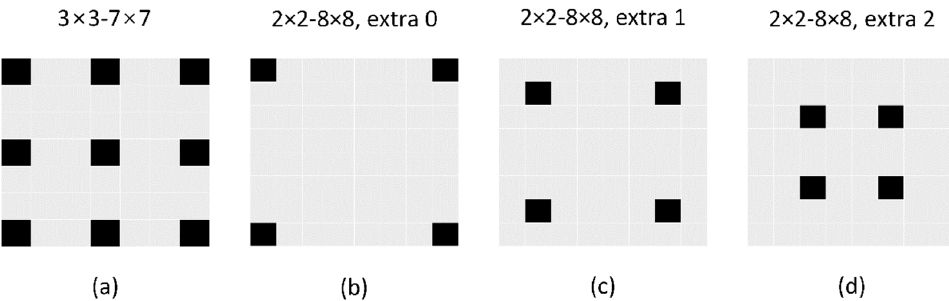
Figure 4. The input–output relationship for different LF reconstruction tasks. ( a ) 3 × 3–7 × 7. ( b ) 2 × 2–8 × 8, extra 0. ( c ) 2 × 2–8 × 8, extra 1. ( d ) 2 × 2–8 × 8, extra 2.